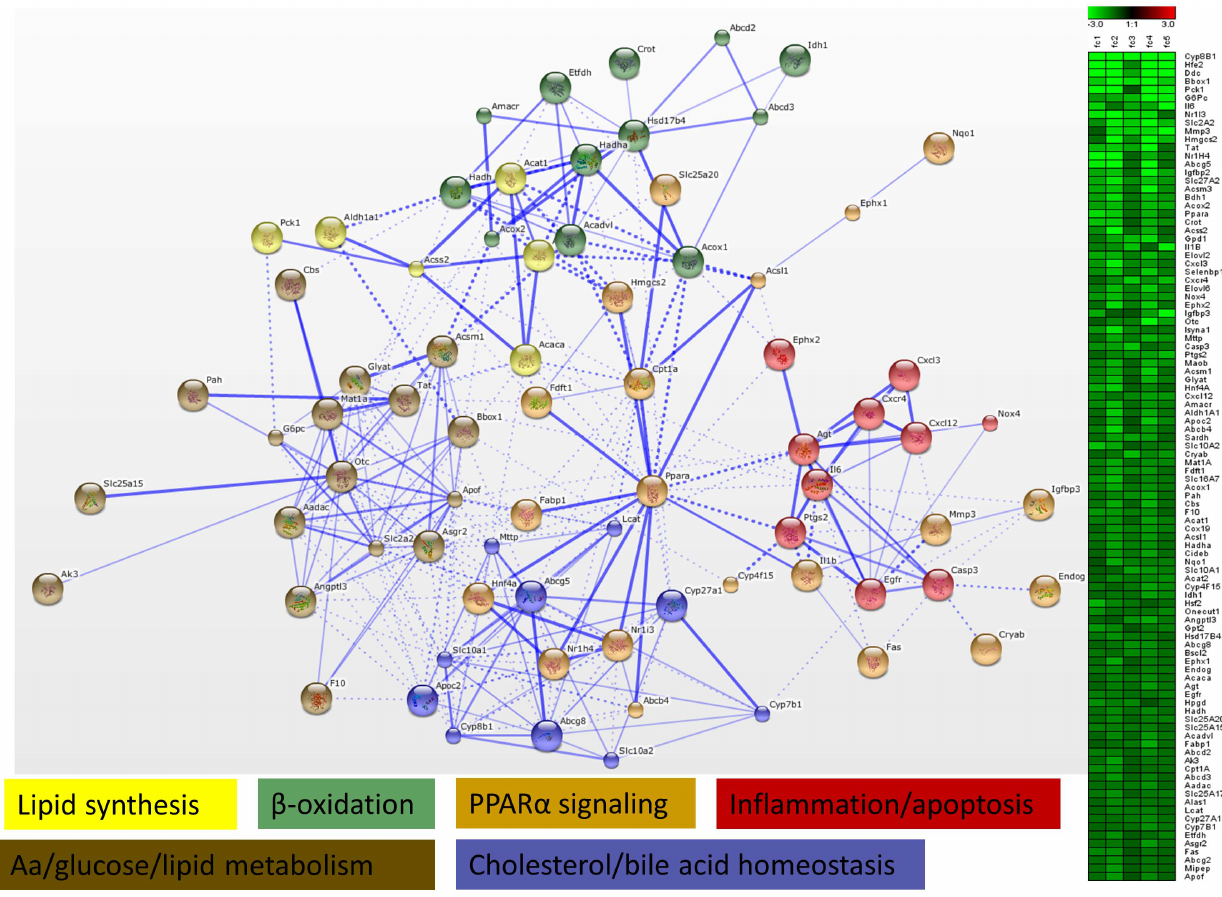
Figure 5. Functional clustering of genes involved in energy metabolism (tetracycline). Genes related to energy metabolism identified by GSEA as being significantly altered upon tetracycline (TET) treatment were subjected to functional clustering in STRING. Functional clusters such as lipid synthesis, b -oxidation, PPAR a signaling, inflammation/apoptosis, amino acids (aa)/glucose/lipid metabolism, and cholesterol/bile acid homeostasis were identified. Information about fold change (FC=treatment vs. control) for the analysed genes in individual mice is presented as a heat map. For explanation of the networks see Fig. 3.